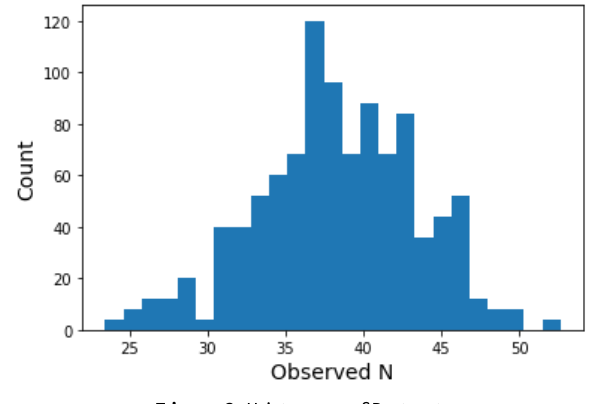
Figure 3 . Histogram of Dataset